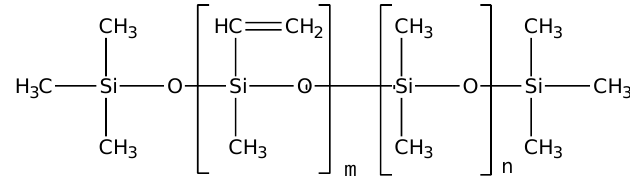
Figure 2. The formula of poly dimethyl siloxane.